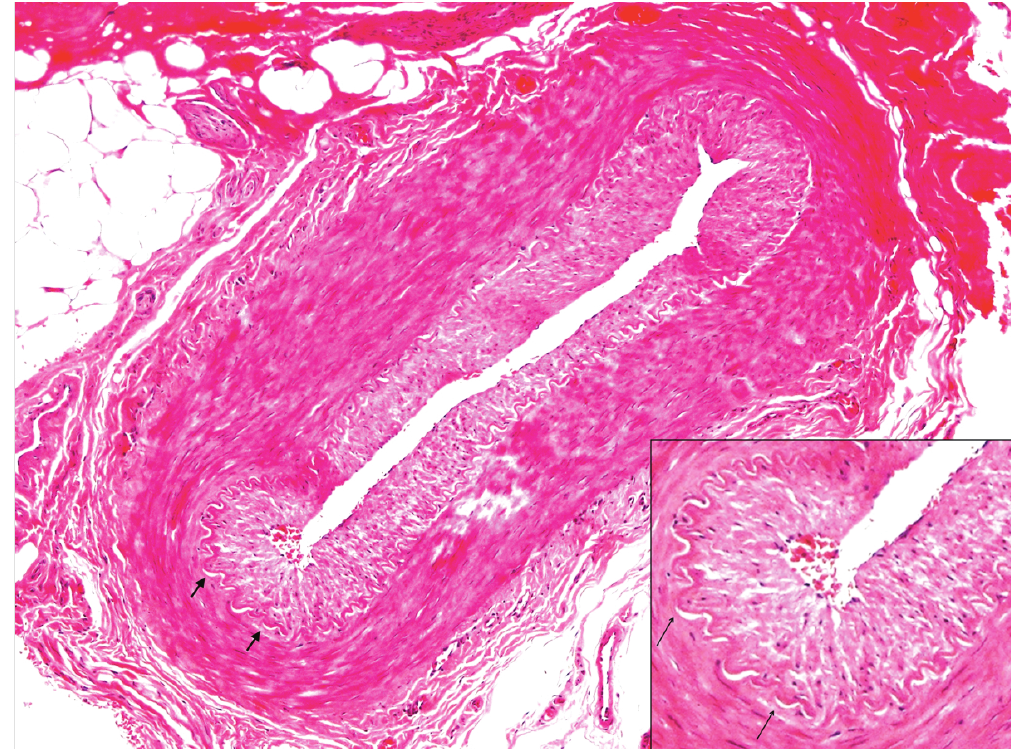
Figure 1. Histopathology section of a negative temporal artery biopsy. Note the intact lamina elasticum (short arrows) and the absence of inflammation (hematoxylin and eosin staining, 100 ×